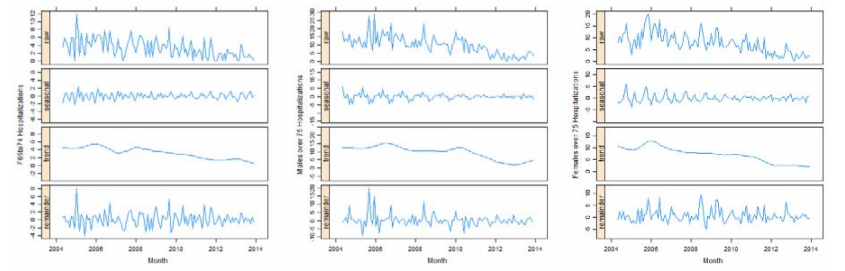
Figure A2. Seasonal trend decomposition for all age-gender specific groups.